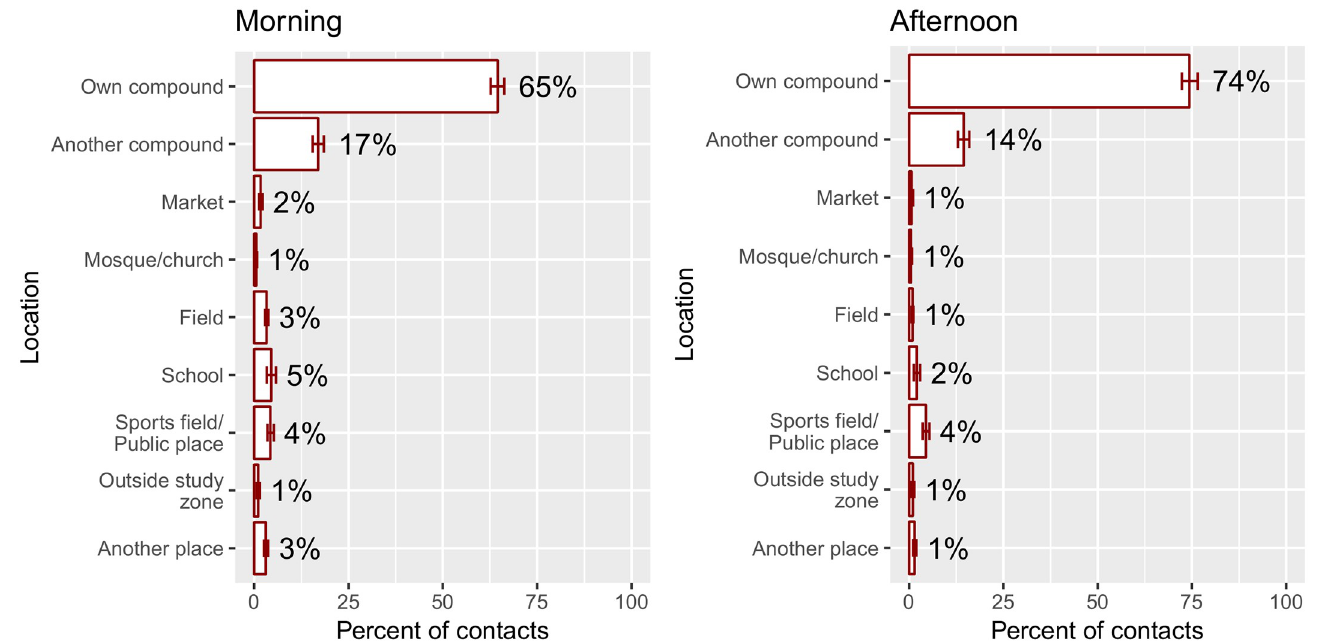
Fig 3. Percentage of contacts occurring in various locations using the multiply imputed data, two days before the survey day, with 95% confidence intervals.